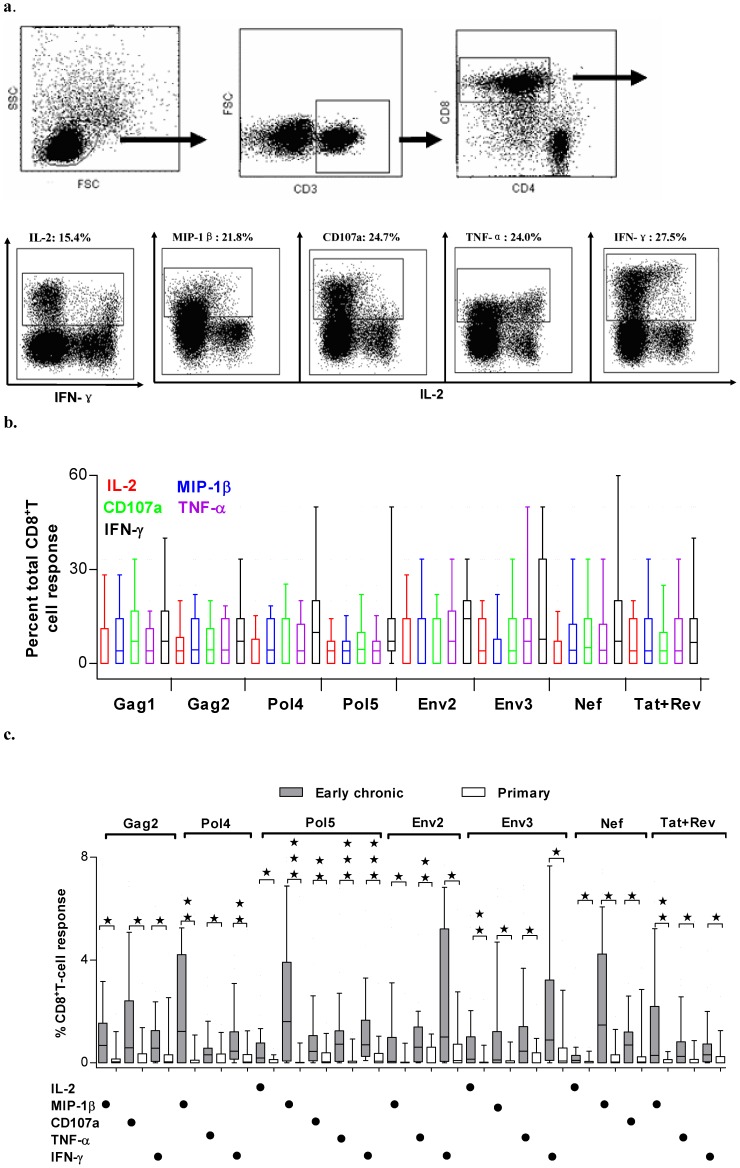
Comparison of the magnitudes of different functional HIV-specific CD8+ T cells between primary and early chronic phase of HIV infection.a. Gating scheme used for the identification of CD8+ T-cell responses. Data shown were from cells derived from one representative patient, stimulated with PMA and ionomycin. Initial gating was performed on lymphocytes in a forward scatter of FSC-A versus FSC-H, and then FSC vs SSC plot. CD3+ events were gated in the FSC versus CD3 plot prior to gating on CD3+CD8+ and CD3+CD4+ events. The resulting CD3+CD4-CD8+ population was further gated based on positivity for each of 5 functional responses including IL-2, MIP-1β, CD107a, TNF-α and IFN-γ. b. The frequencies of five distinct functions (color coded as shown) in the total CD8+ T-cell response against the indicated HIV peptide mix (x-axis) within 55 HIV-infected MSM. c. Comparison of the magnitude of different functional HIV-specific CD8+ T cells between primary and early chronic infection groups. For simplicity, only significantly different populations were shown for Gag1, Gag2, Pol4, Pol5, Env2, Env3, Nef and Tat+Rev responses; no significant differences were identified for those functions not shown. The responses from 55 HIV-infected MSM were standardized so that the profiles could be compared irrespective of any frequency differences. Asterisks were placed above response pairs that were significantly different: ***p<0.001; **p<0.01 and *p<0.05. Each dot denoted a positive response for the function indicated at the bottom left. The box plots represented the 10th, 25th, 75th, and 90th percentiles.